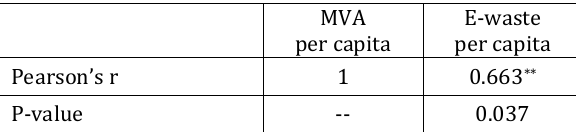
Table 4. Correlation results